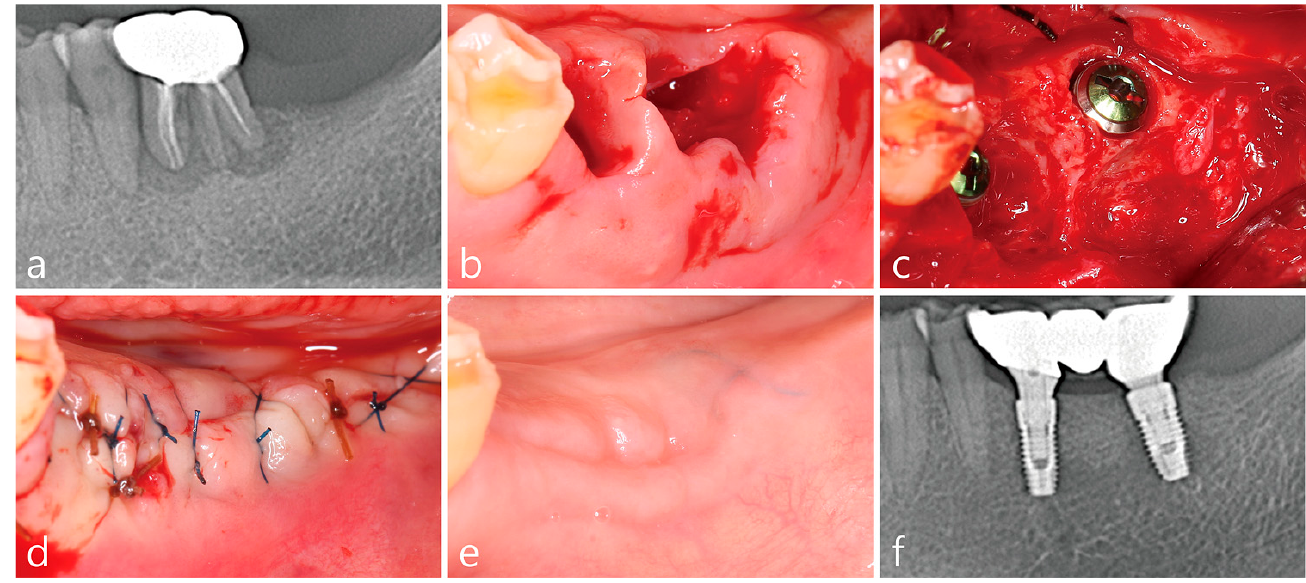
Figure 6. Clinical and radiological findings of case #6. ( a ) Pre-operative panoramic radiograph showing severe bone resorption around #35 and 36. ( b ) Compromised sockets #35, 36. ( c ) #35, 36 implant placement with peri-implant osseous defect. Flap extension by dissection of the ICT attached to the buccal flap with the base attached to the existing flap. Bone graft placement over #36 implant. ( d ) Flap closure with extended IGT. ( e ) Post-operative photograph showing healing with no flap exposure. ( f ) Panoramic radiograph taken 26 months after prosthesis delivery.